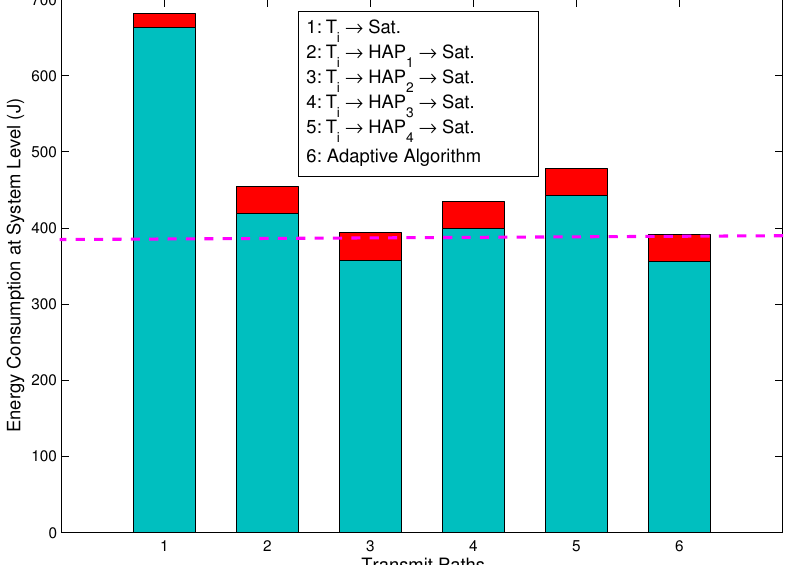
Figure 4. Total energy consumption for the direct link, relay links and adaptive path selection at the system